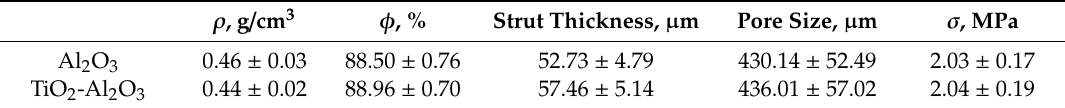
Table 1. Properties of Al 2 O 3 foam substrate and TiO 2 -coated Al 2 O 3 foam.